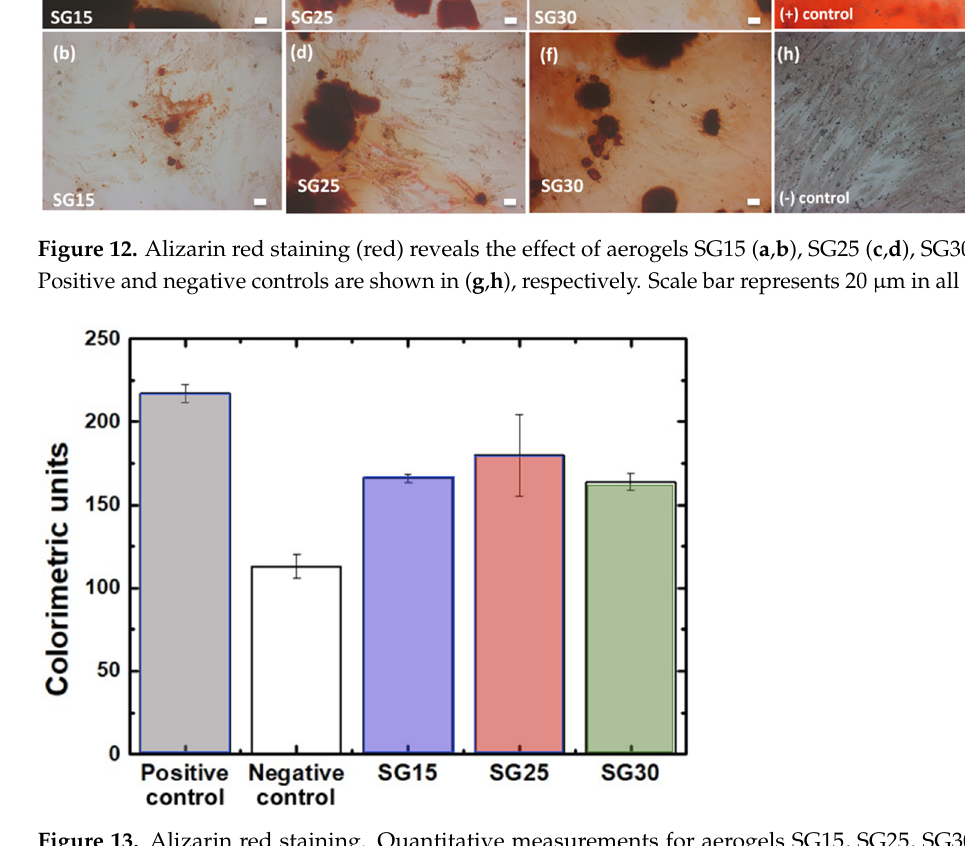
Figure 13. Alizarin red staining. Quantitative measurements for aerogels SG15, SG25, SG30 and controls. One-way analysis of variance. Statistical significance was defined as p < 0.05.